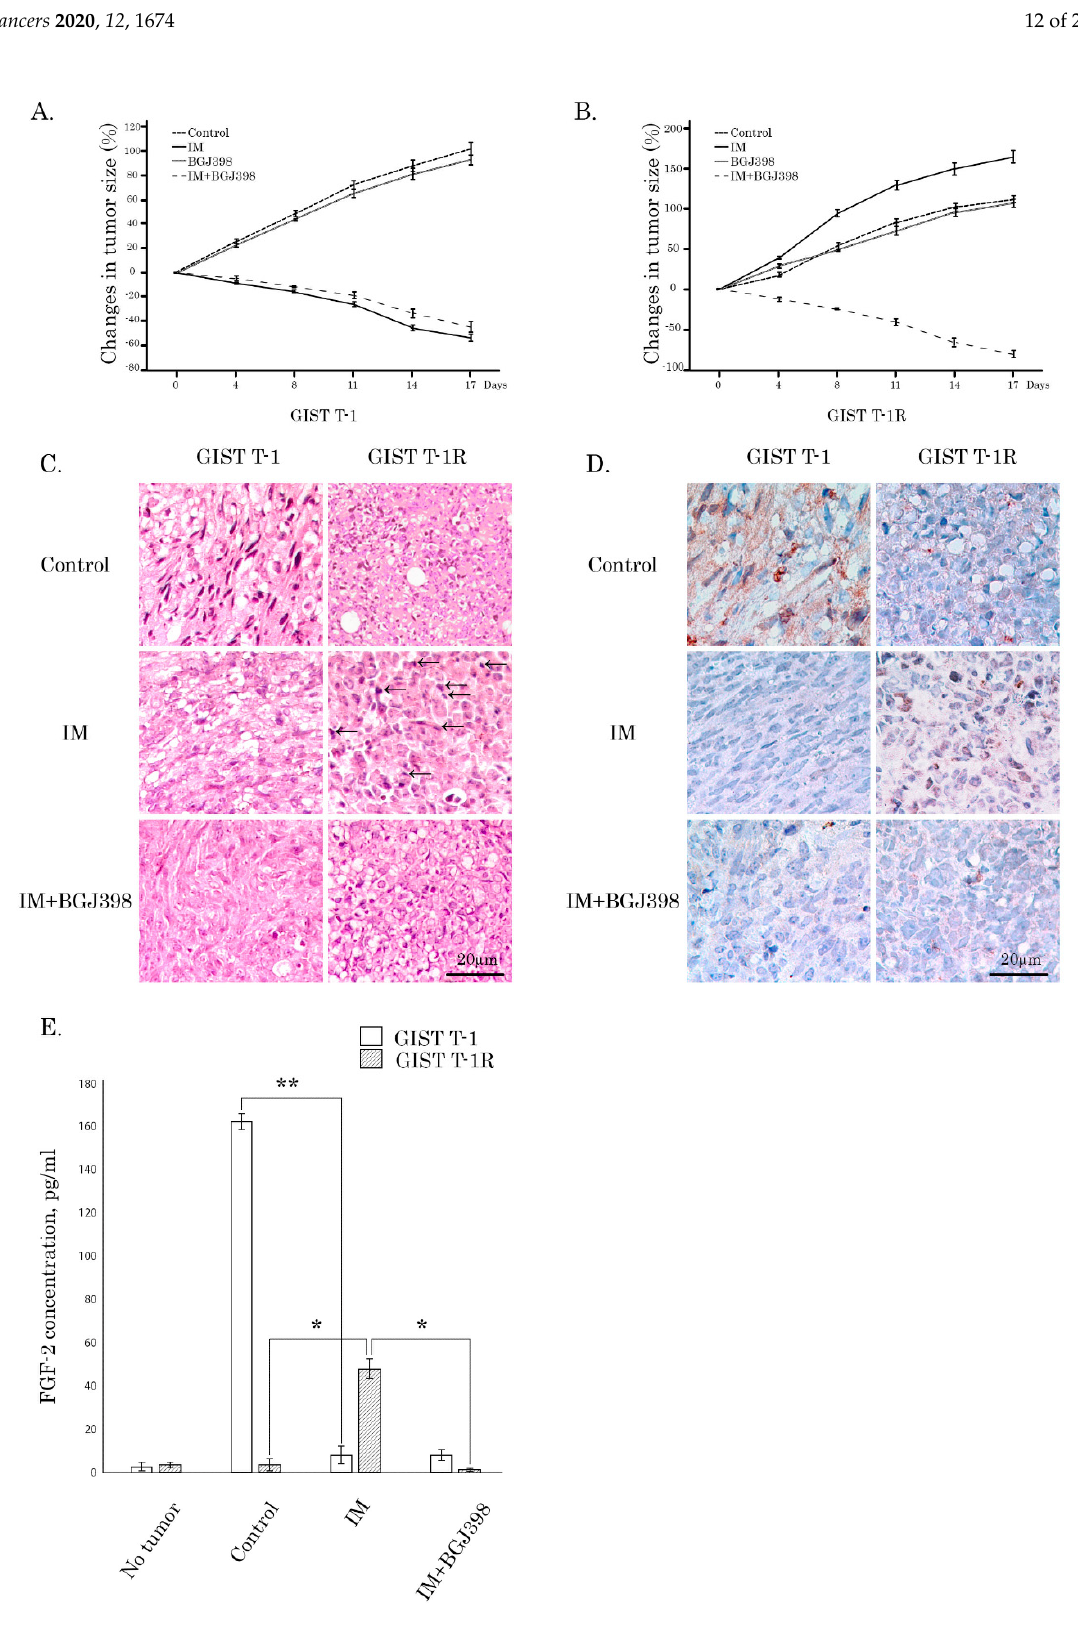
Figure 6. IM activates FGF ‐ signaling in IM ‐ resistant GIST xenografts. ( A , B ) Changes in the tumor volume of IM ‐ naive (T ‐ 1) and resistant (T ‐ 1R) xenografts (A and B, respectively). Nude mice bearing GIST T ‐ 1R xenografts were orally administered with 50 μ L of IM (50 mg/kg) or BGJ398 (60 mg/kg) alone or in combination. Mice treated with the same volume of the vehicle were used as a negative control. GIST T ‐ 1R xenografts were also treated with IM alone or in the presence of BGJ398. The changes in tumor size were calculated as a percentage of the baseline. GIST T ‐ 1R cells were